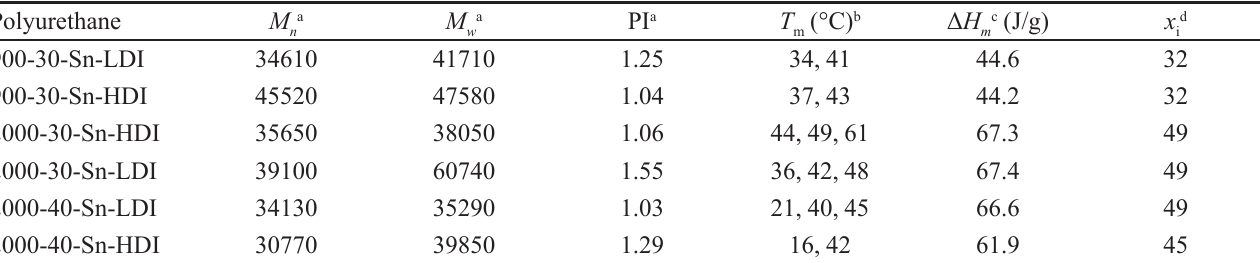
), weight - average molecular weight ( M n